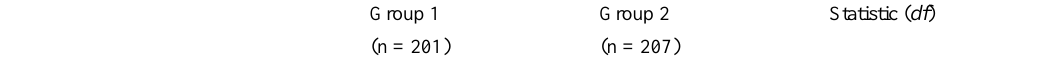
P valueStatistic ( df )Group